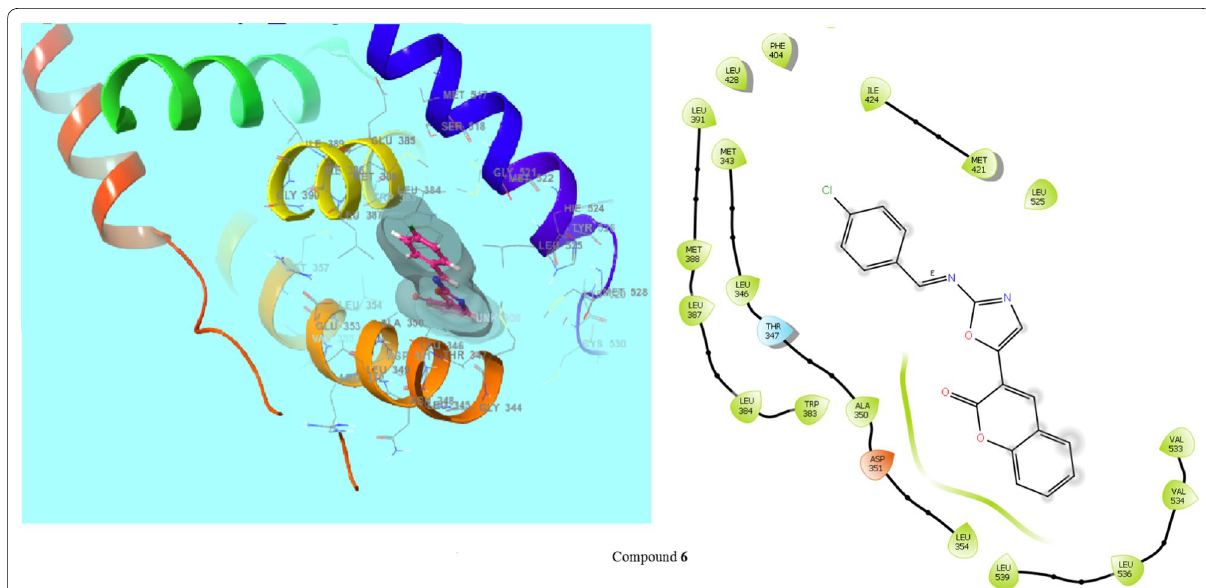
Fig. 8 Interaction of compound 6 and tamoxifen within the active pocket of 3ERT protein and interacting amino acid in 2D view